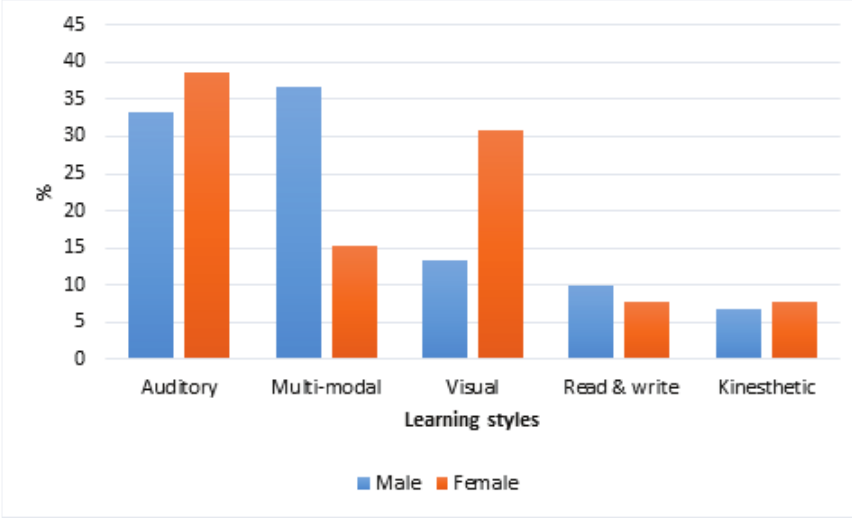
Figure 3. Distribution of VARK’s learning styles according to gender.